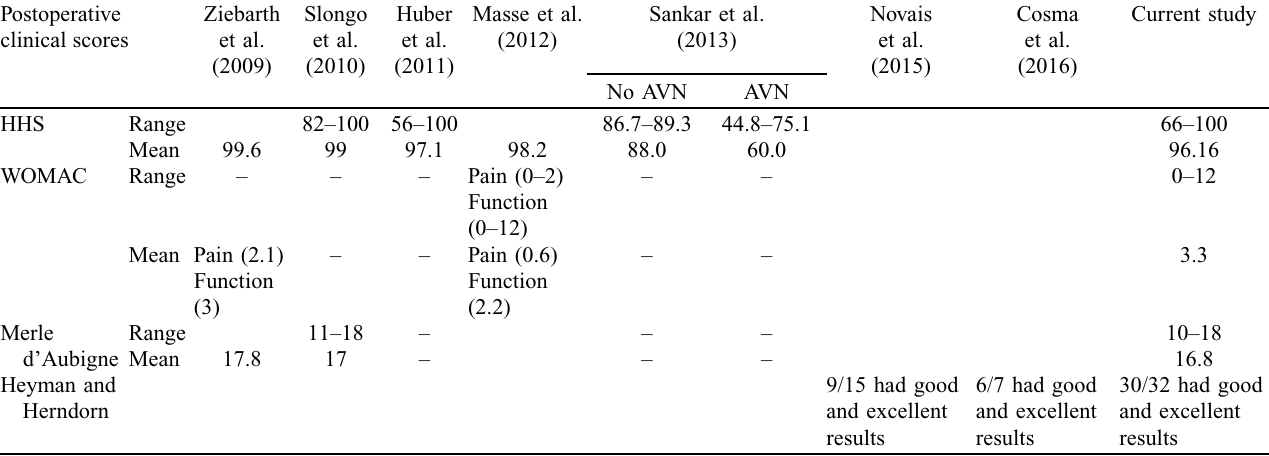
Table 5. Comparison of postoperative clinical scores in different studies.